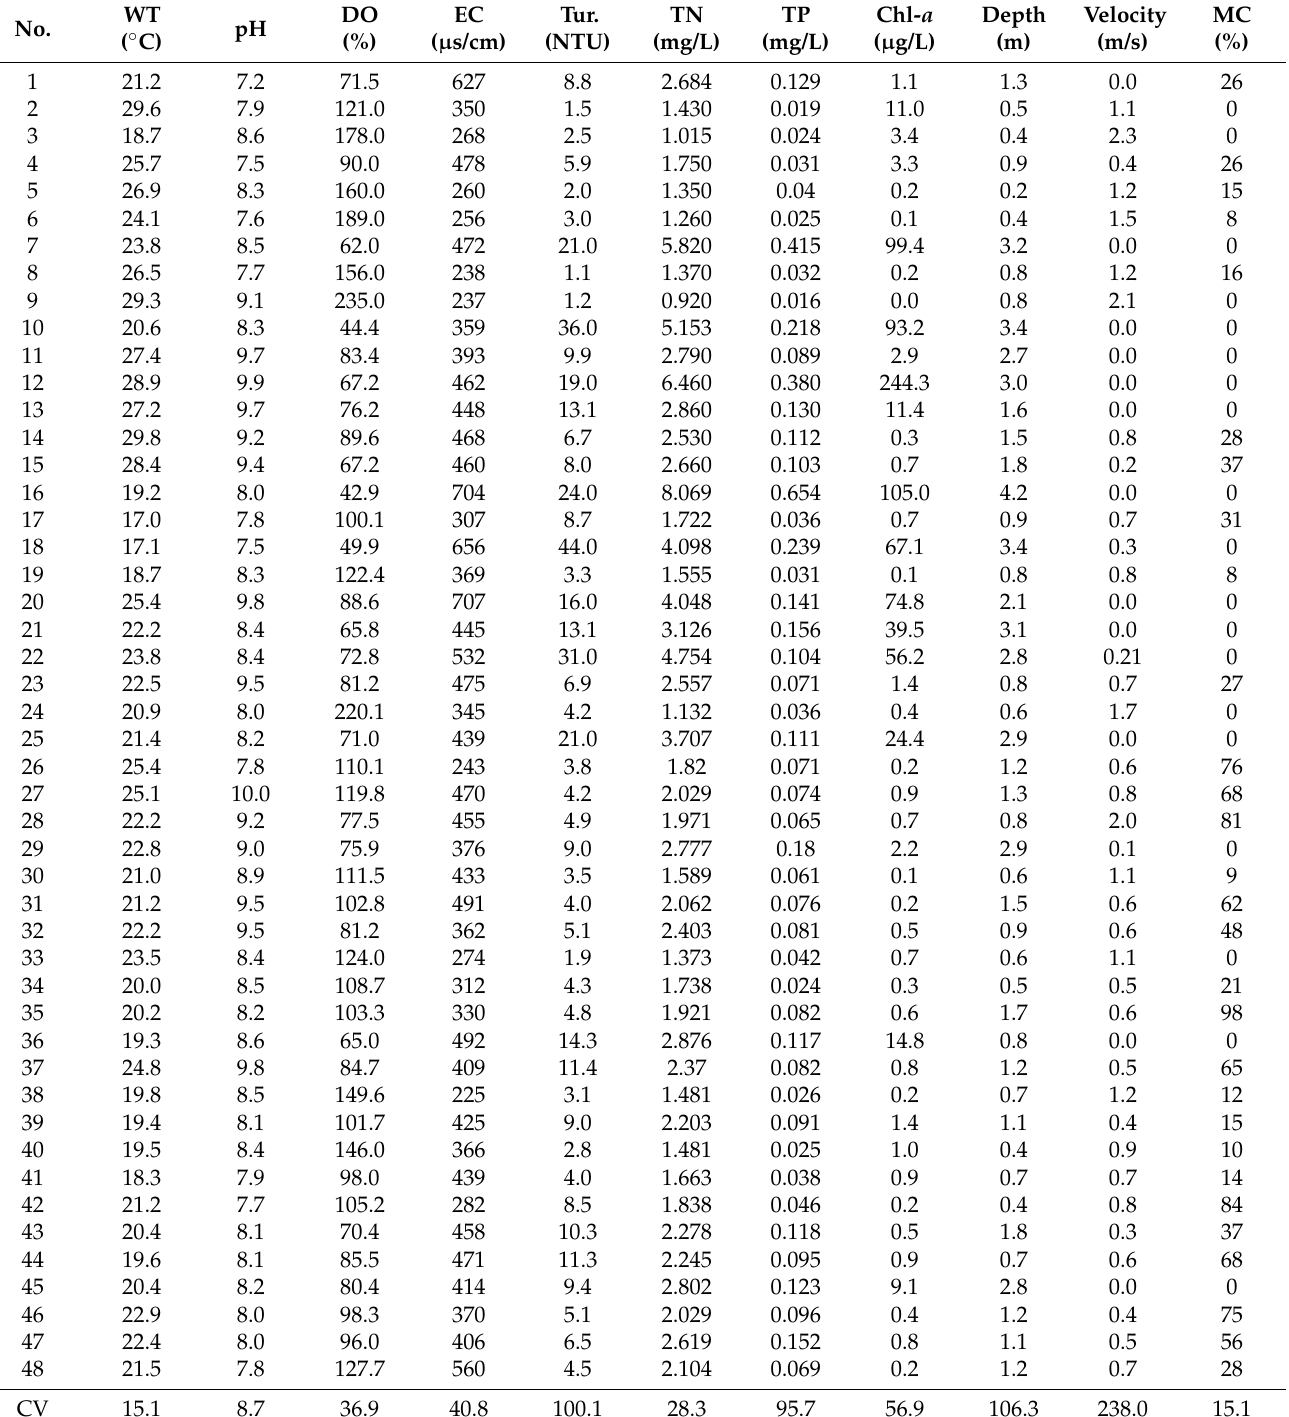
Table 2. Environmental factors in 48 artificially created riverine wetlands: WT, water temperature; DO, dissolved oxygen; EC, conductivity; Tur., turbidity; TN, total nitrogen; TP, total phosphorus; Chl- a , chlorophyll a ; MC, macrophyte coverage; SD, standard deviation; CV, coefficient of variation